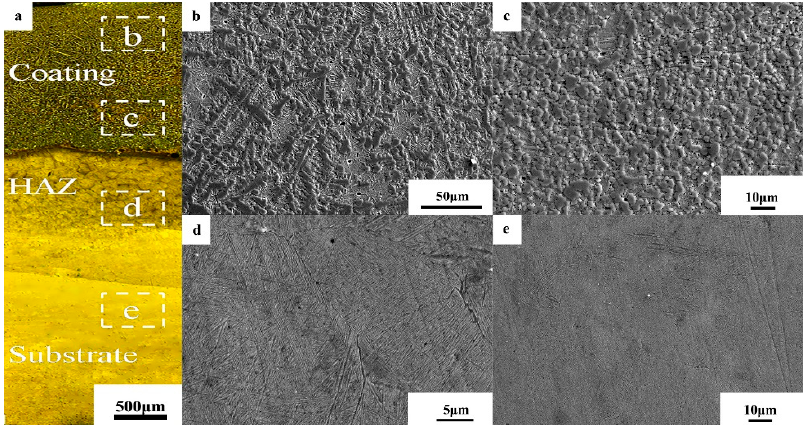
Figure 5. ( a ) Optical microscope (OM) microstructures of the cross-section of sample 30ZrN, SEM